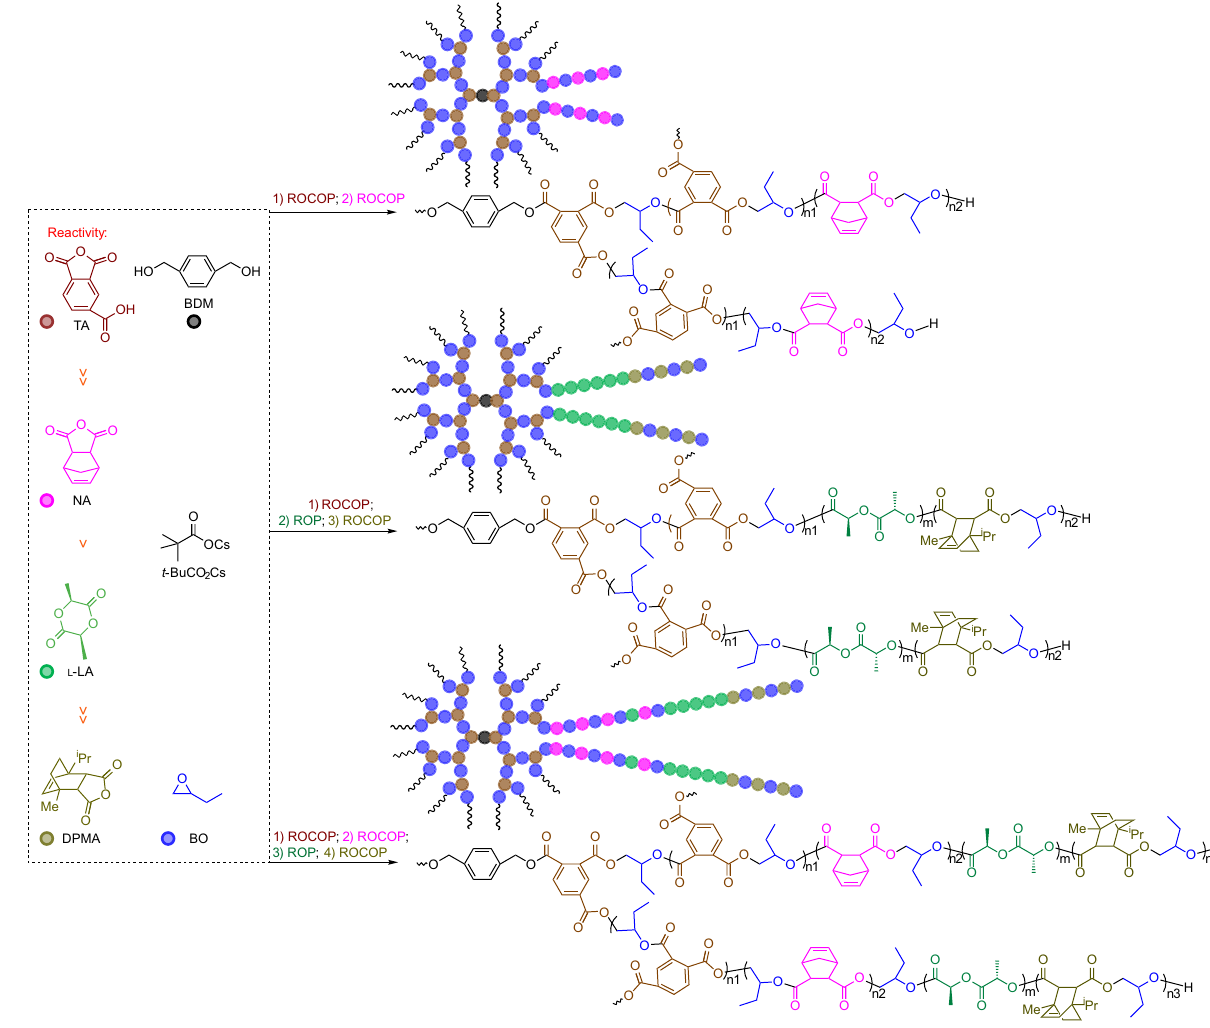
Fig. 8 The one-step synthesis of various core – shell-type multiblock copolymers by the combination among different catalytic cycles at 80 °C. Brown: TA. Pink: NA. Green: L -LA. Olive: DPMA. Blue: